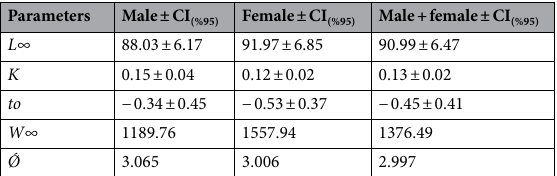
Table 2. VBGE parameters of M. mastacembelus population inhabiting Keban Dam Lake, according to sexes.